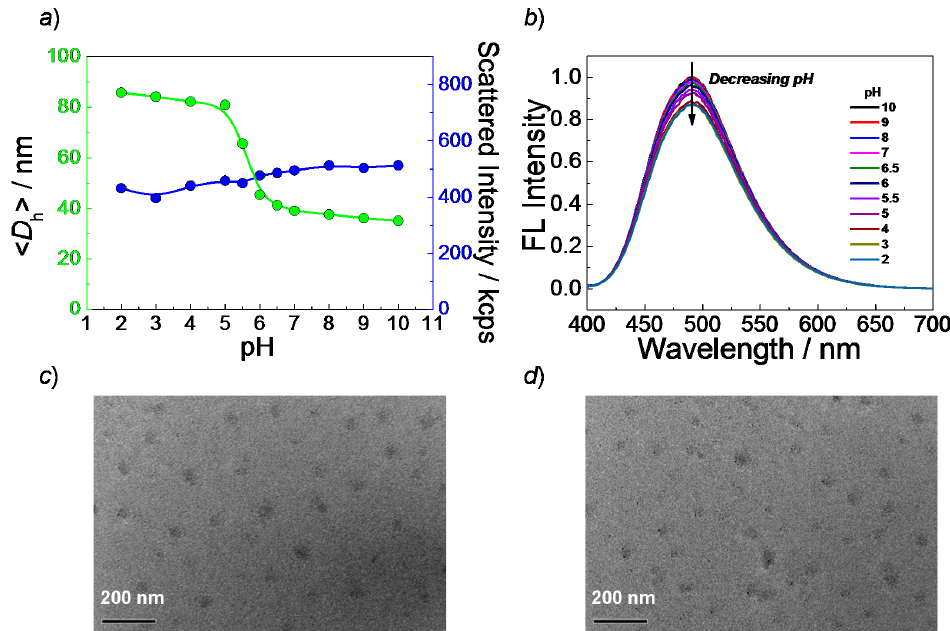
Figure 1. ( a ) Variations of hydrodynamic diameters, D h , and corresponding scattered light intensity changes obtained for 1.0 g/L aqueous solution ( BP2 / BP3 = 9/1, wt %, 25 °C) of CCL(core cross-linked) micelles at varying pH values; ( b ) pH-dependence of normalized fluorescence emission spectra recorded for 1 g/L aqueous solution of the CCL micelles (25 °C, λ ex = 390 nm; slit widths: Excitation 5 nm, Emission 5 nm) with pH decreasing from 10 to 2. TEM images of CCL micelles at ( c ) pH 10 and ( d ) pH 2.